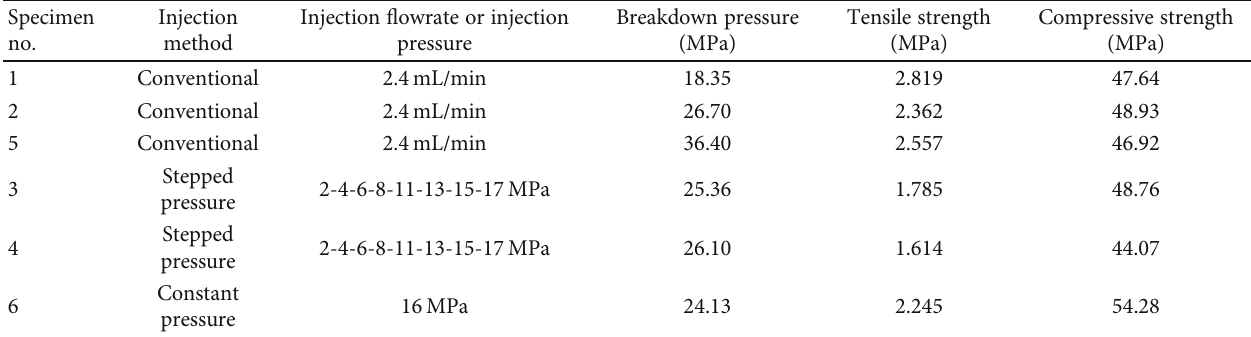
Table 3: Results summary for the second batch of sandstone.